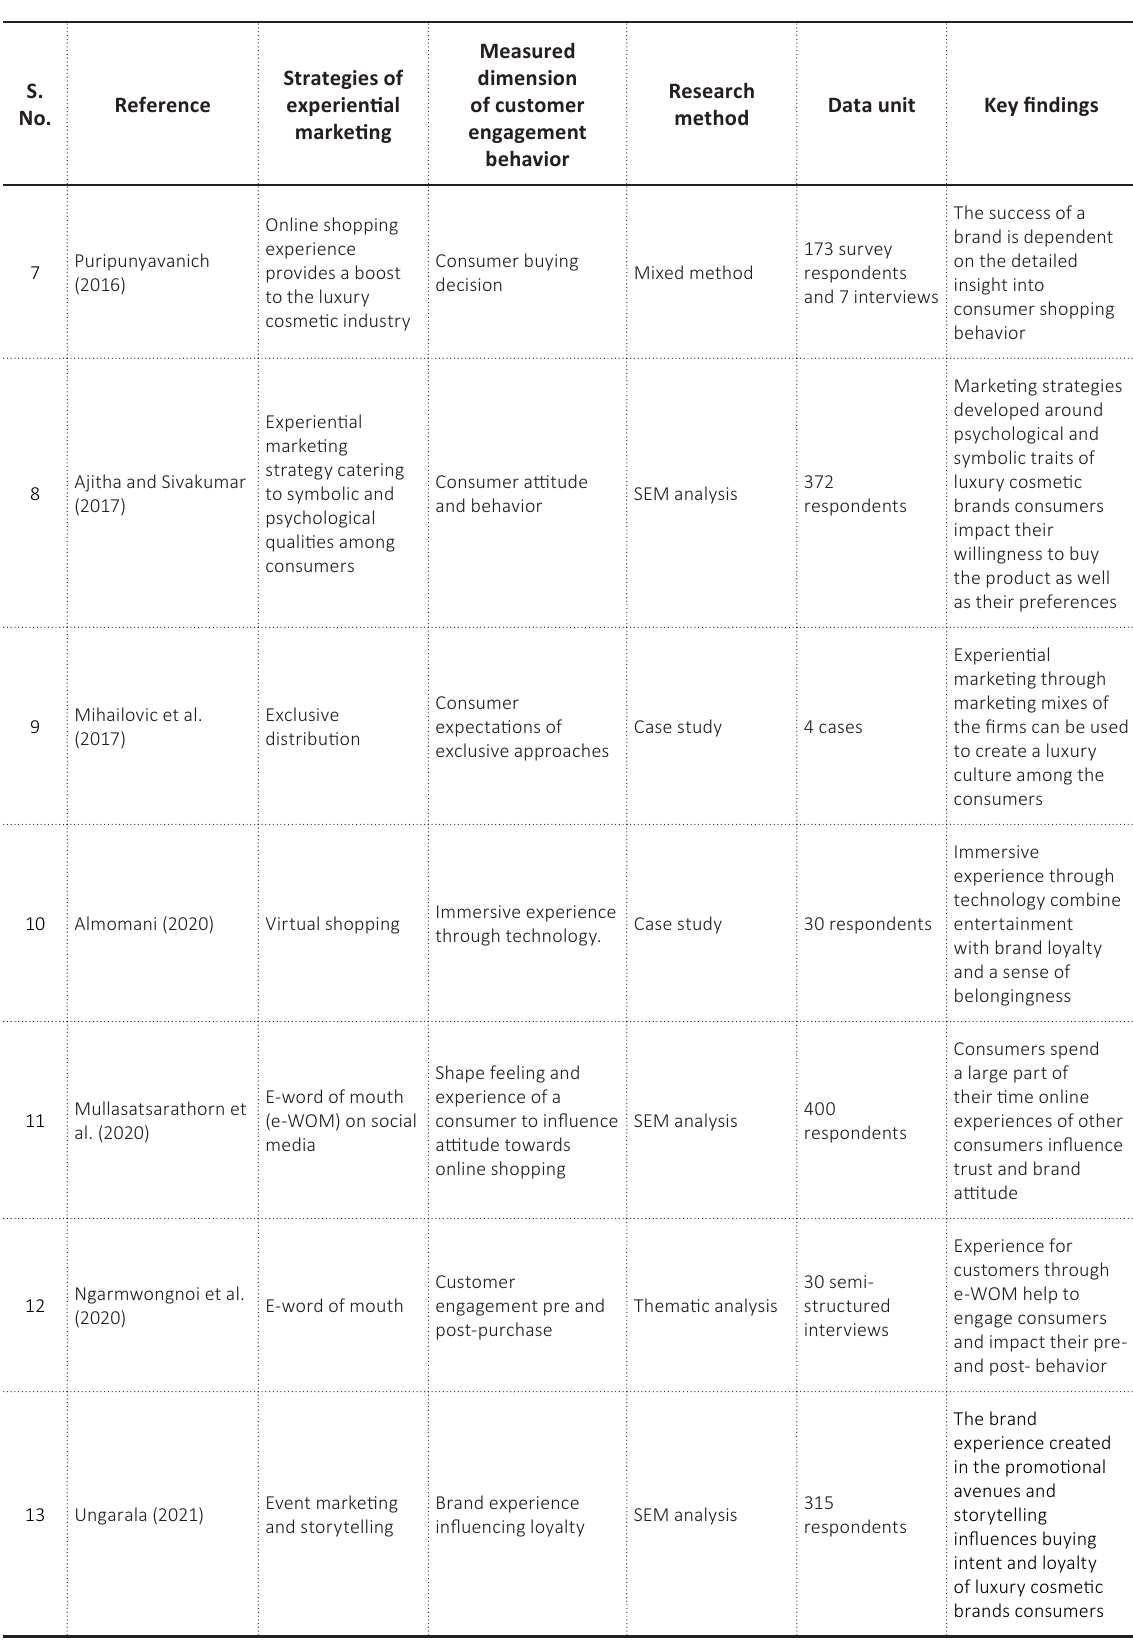
Table 1 (cont.). Strategies of experiential marketing used by luxury cosmetics companies